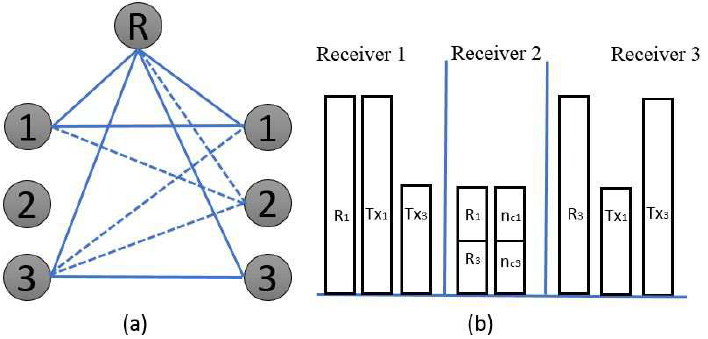
Figure 6. ( a ) simple network topology over the third time slot and ( b ) block representation of the received